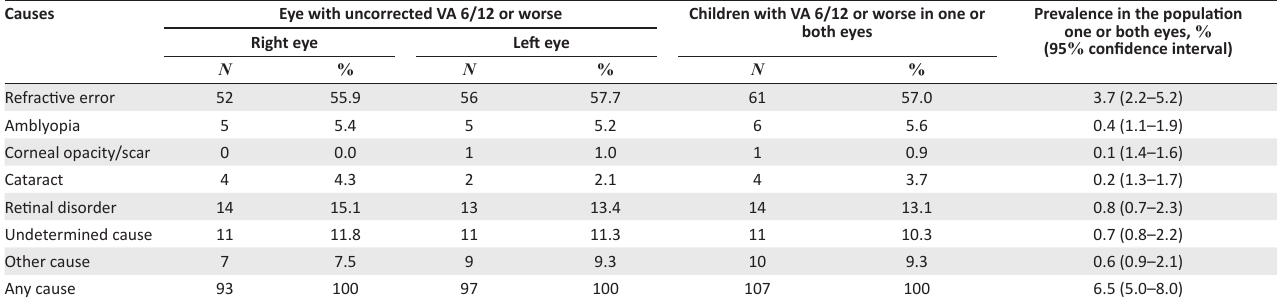
TABLE 5: Causes of uncorrected visual acuity 6/12 or worse. Causes Eye with uncorrected VA 6/12 or worse Children with VA 6/12 or worse in one or